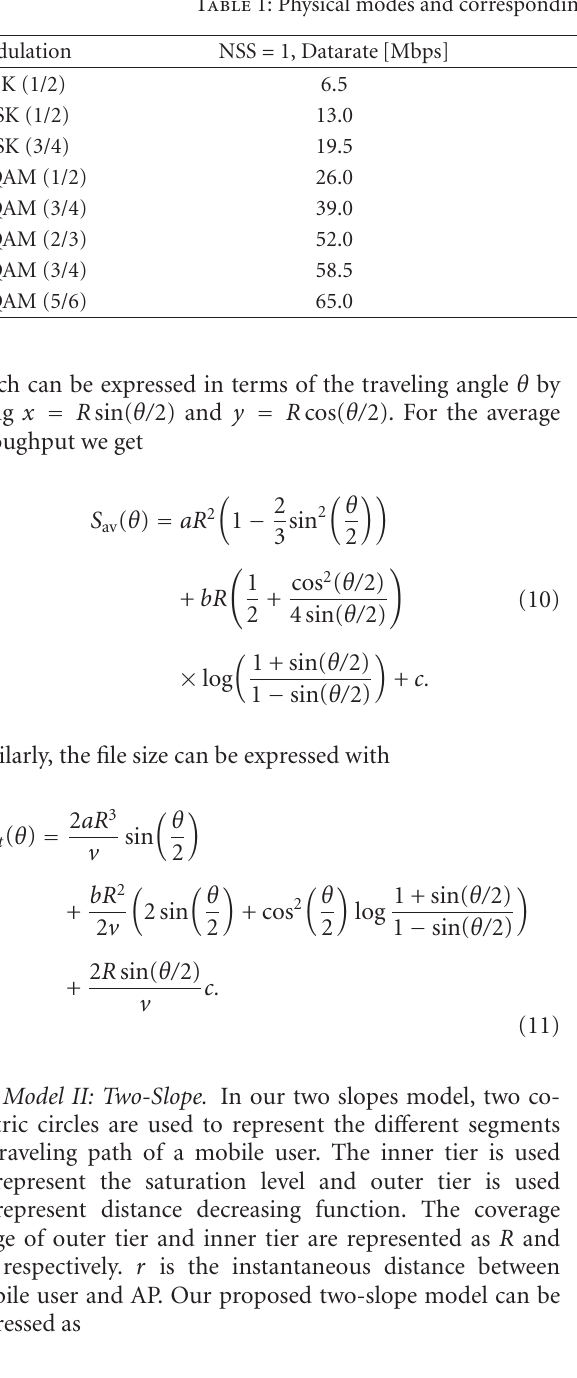
Table 1: Physical modes and corresponding throughput, NSS, receiver sensitivity